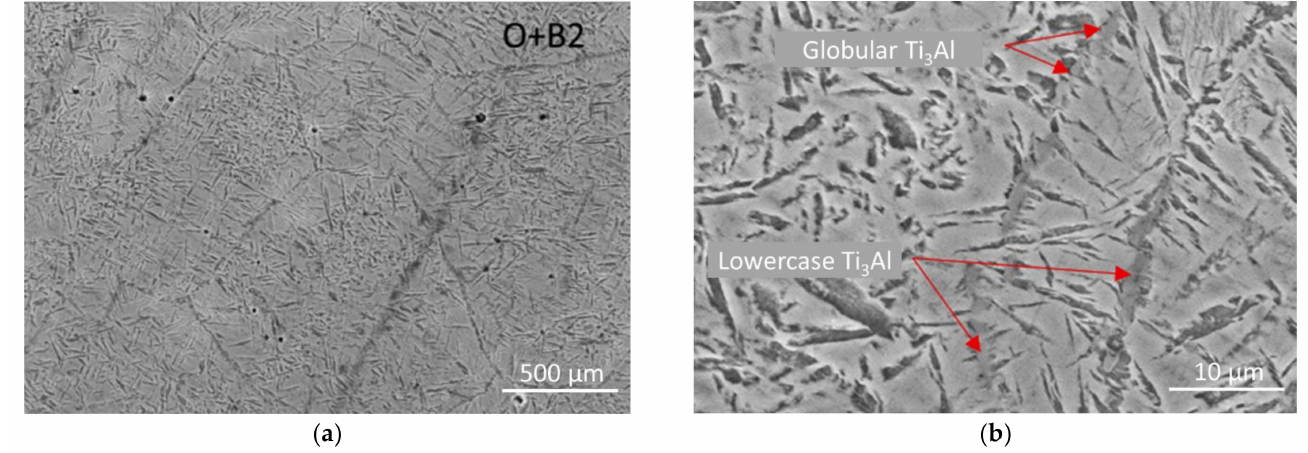
Figure 9. Structure of IMC samples of the Ti-Al-Nb system after two-stage heat treatment: ( a ) × 500; ( b ) ×